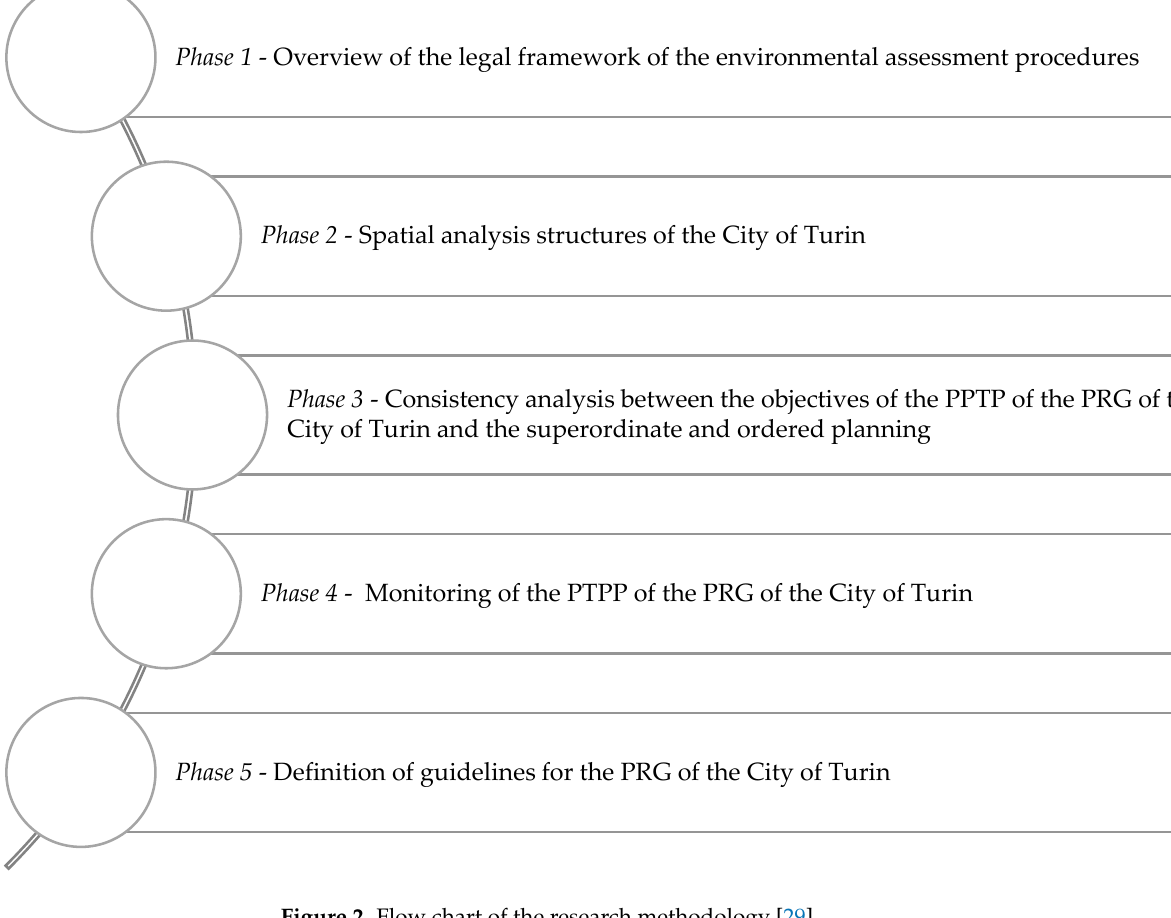
Figure 2. Flow chart of the research methodology [29].